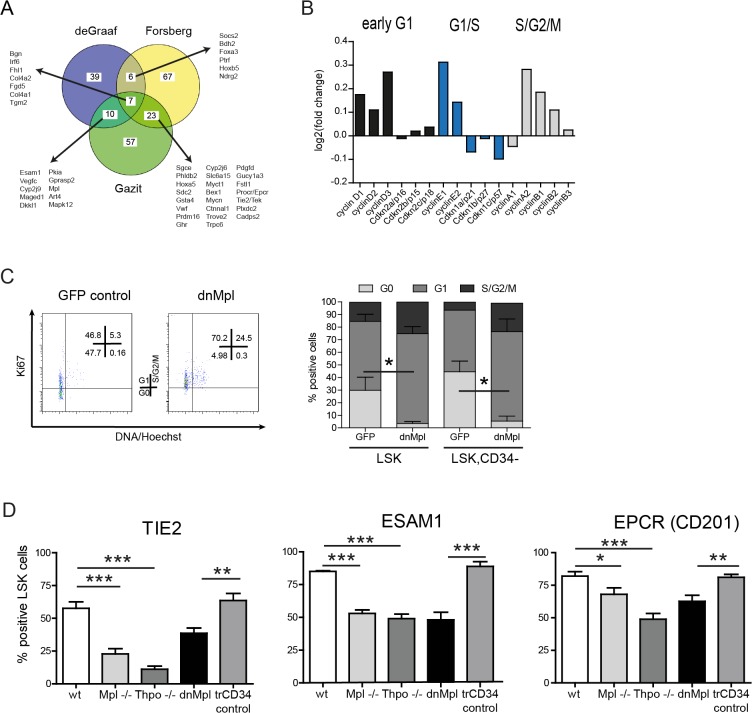
Cell cycle analysis and cell surface molecule expression on LSK cells in dnMpl mice.(A) Venn diagram showing the overlap of the leading edge genes from the Gene Set Enrichment Analysis comparing our dataset with the data of [15,34,54]. (B) Expression of essential players in the cell cycle control. Displayed are the log2(fold-change) values determined based on the microarray analysis in comparison to control. (C) Cell cycle analysis of LSK cells of dnMpl and GFP control transplanted mice. Total BM cells were stained and gated for the LSK or LSK, CD34- cell population. Cell cycle status was determined by staining with Ki-67 and Hoechst 33342. A representative example of the flow cytometric analysis is shown (left picture) and the results summarized (right graph). Significantly less LSK and LSK, CD34- cells are within the G0 phase of the cell cycle (*p<0.05, n = 3). (D) Wild-type mice were transplanted with dnMpl or truncated (tr)CD34 (as control) expressing BM cells. At 16 weeks post transplantation total BM cells were stained for LSK cells, each BM sample was then splitted into three subsamples to stain for the different surface molecules: TIE2, EPCR (CD201), ESAM1. As controls, cell surface expression was also detected in untransplanted wt, Mpl-/- and Thpo-/- mice. The difference between the percentages of surface marker positive cells was significant, as indicated: *p<0.05, **p<0.01, ***p<0.005. (wt, Mpl-/-, Thpo-/-: n = 6; dnMpl, trCD34: n = 9).